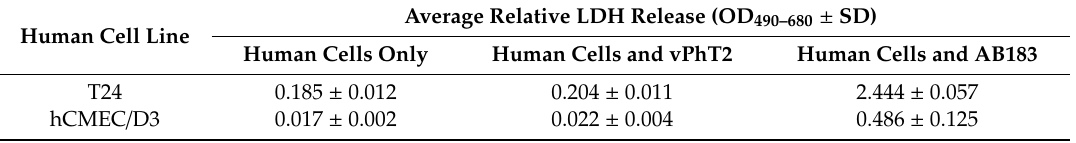
baumannii (in the absence of bacteriophages) compared to no bacterial infection (Table 7), indicating that the presence of A. baumannii was cytotoxic. Table 7. Raw data for lactate dehydrogenase levels (OD 490 - OD 680 ) released by different human cell lines treated with Acinetobacter baumannii or vPhT2 compared to no treatment.